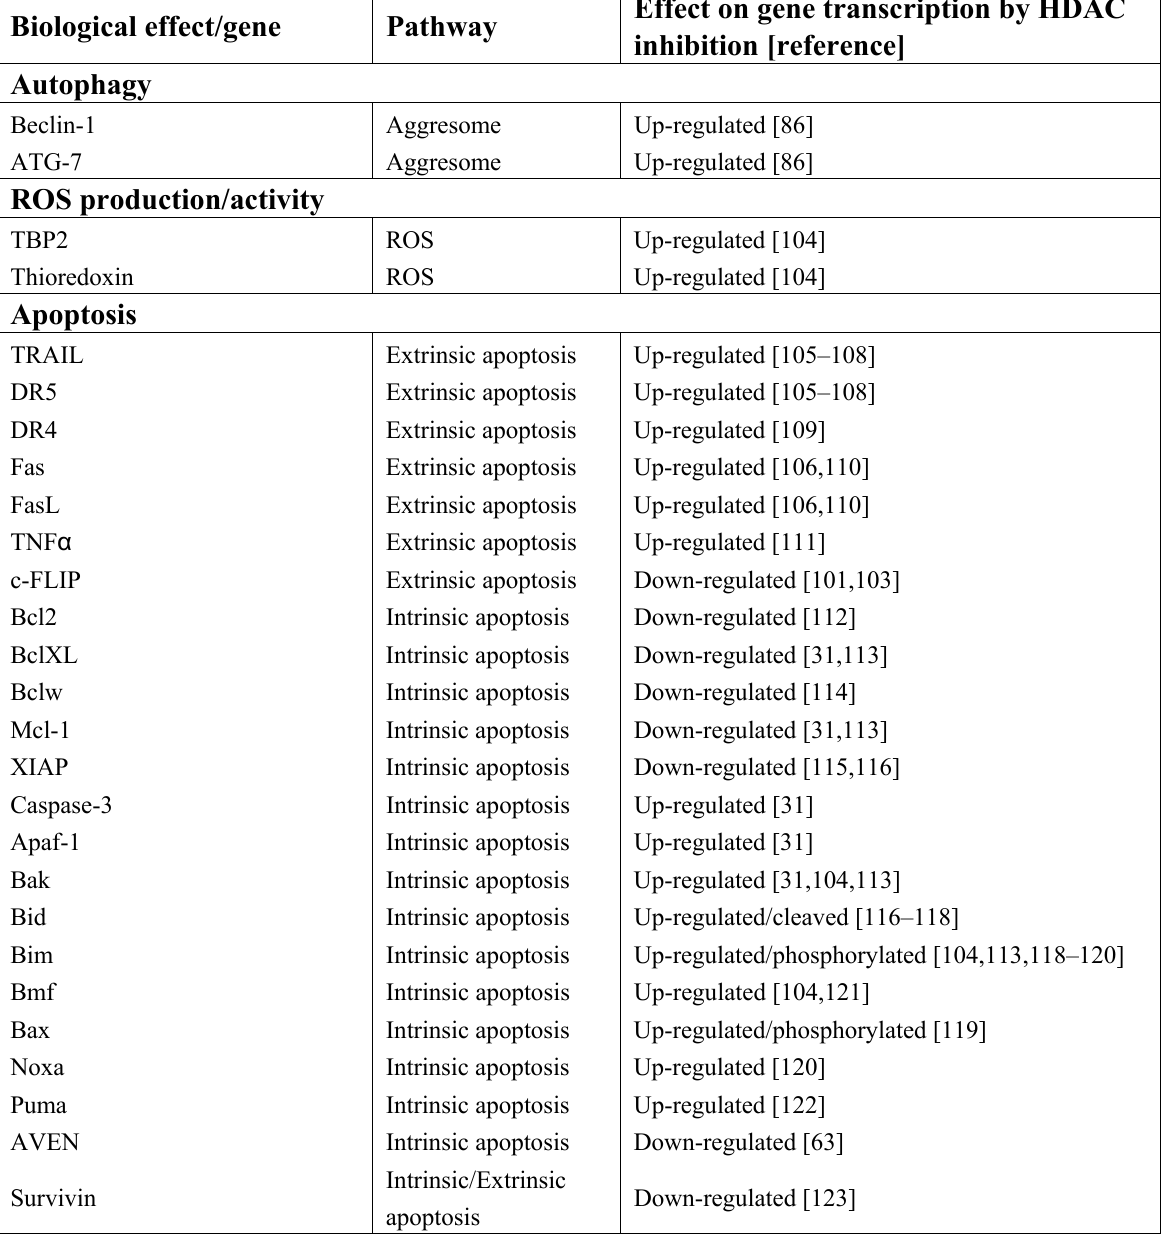
Table 3. Apoptotic and Autophagy related genes regulated by